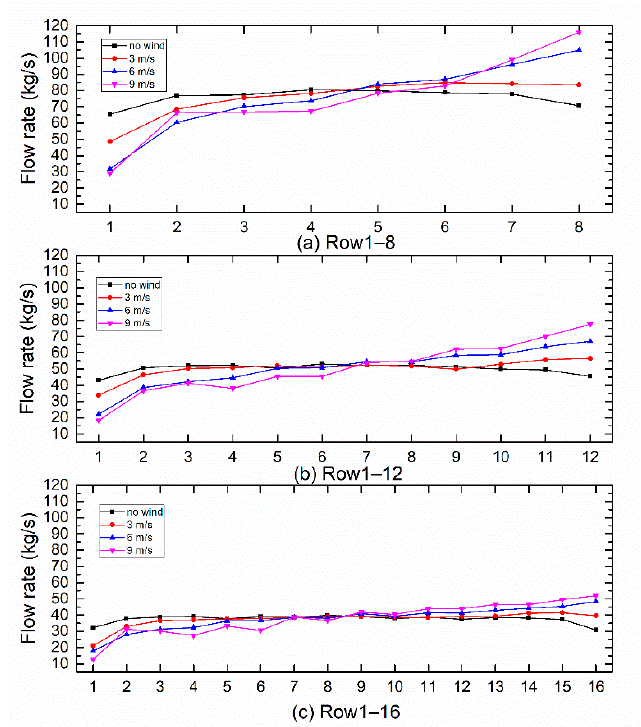
Figure 8. Steam flow distribution under different operation strategies and different wind speeds with the ambient temperature of − 15 °C.